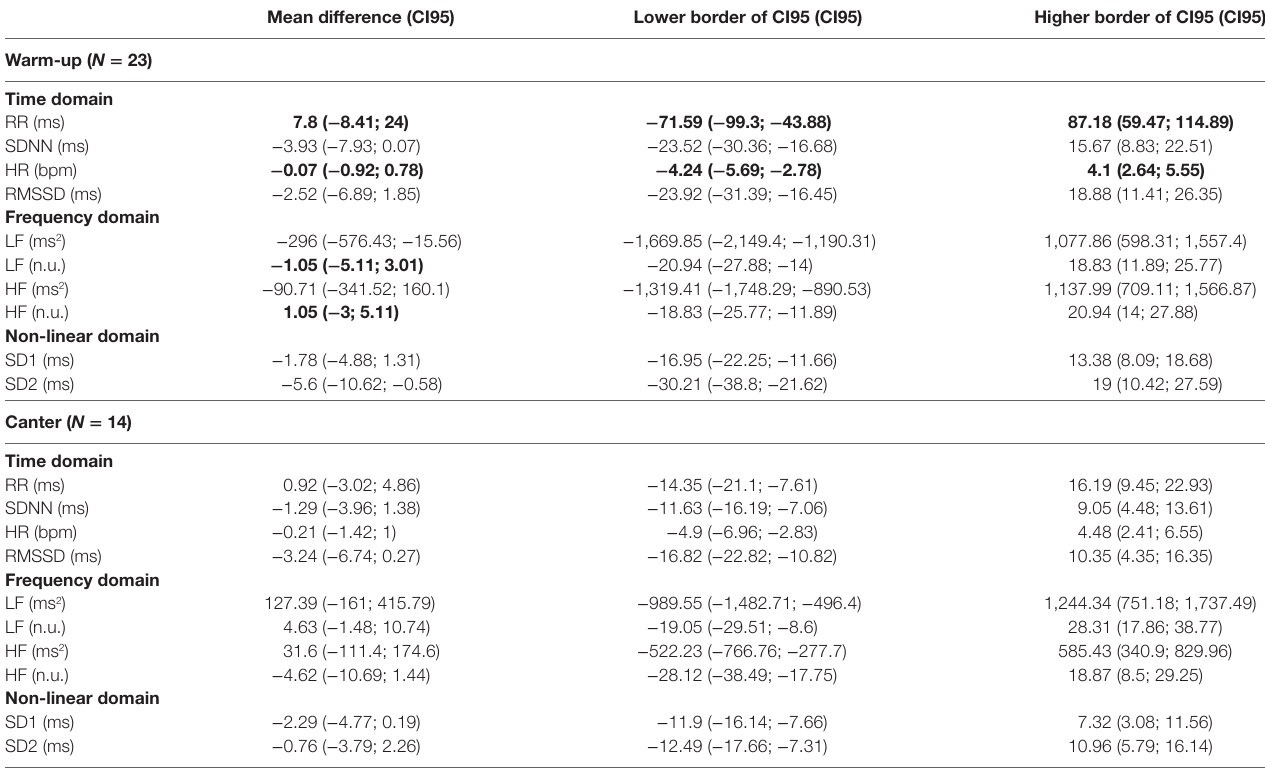
TaBle 2 | Results of the Bland and Altman analysis for recordings obtained during the warm-up phase and canter phase. Mean difference